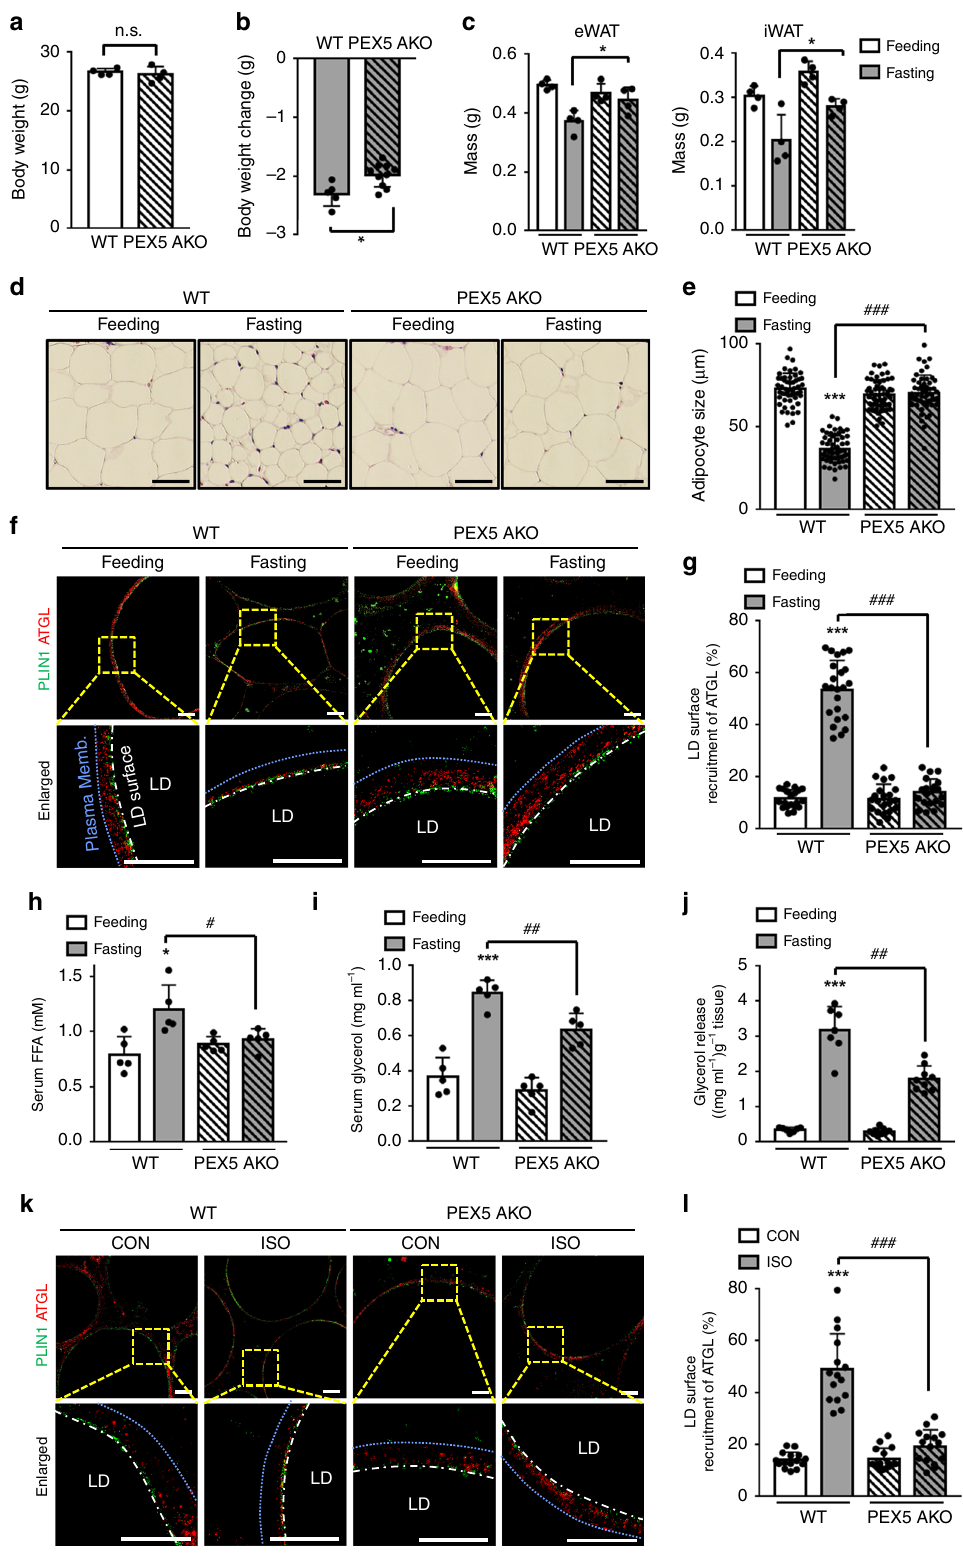
incubated with plus and minus secondary PLA probes against both rabbit and mouse IgG. The incubation was followed by hybridization and ligation, and then ampli fi cation was performed. After mounting with DuoLink-mounting medium, the samples were examined using an OMX SIM microscope and LSM 700 confocal